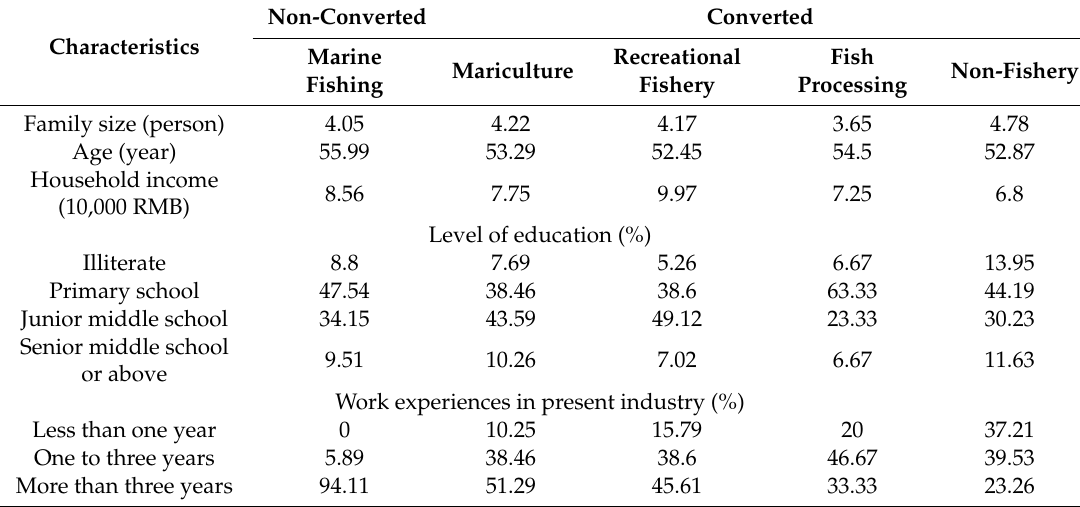
Table 2. Characteristics of converted and non-converted fishermen.